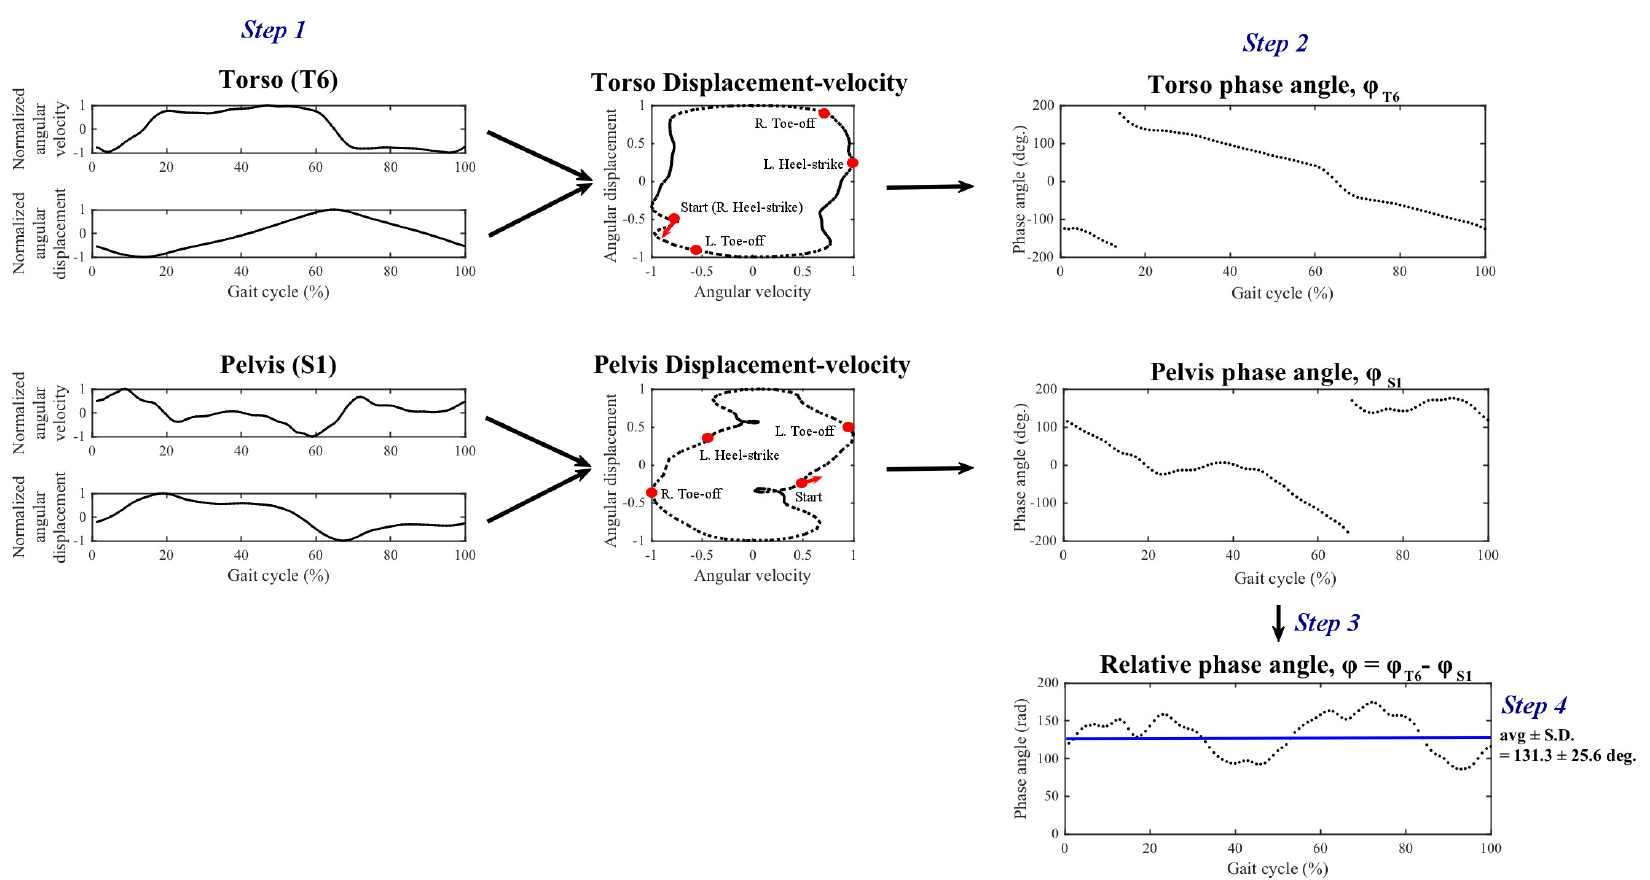
Figure A3. Overview of the algorithm for computing mean thoracic-pelvic relative phase angle using one exemplar participant data from the no-load condition in the coronal